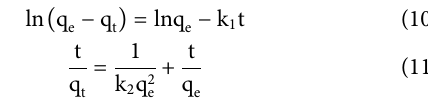
Frontiers in Environmental Chemistry |